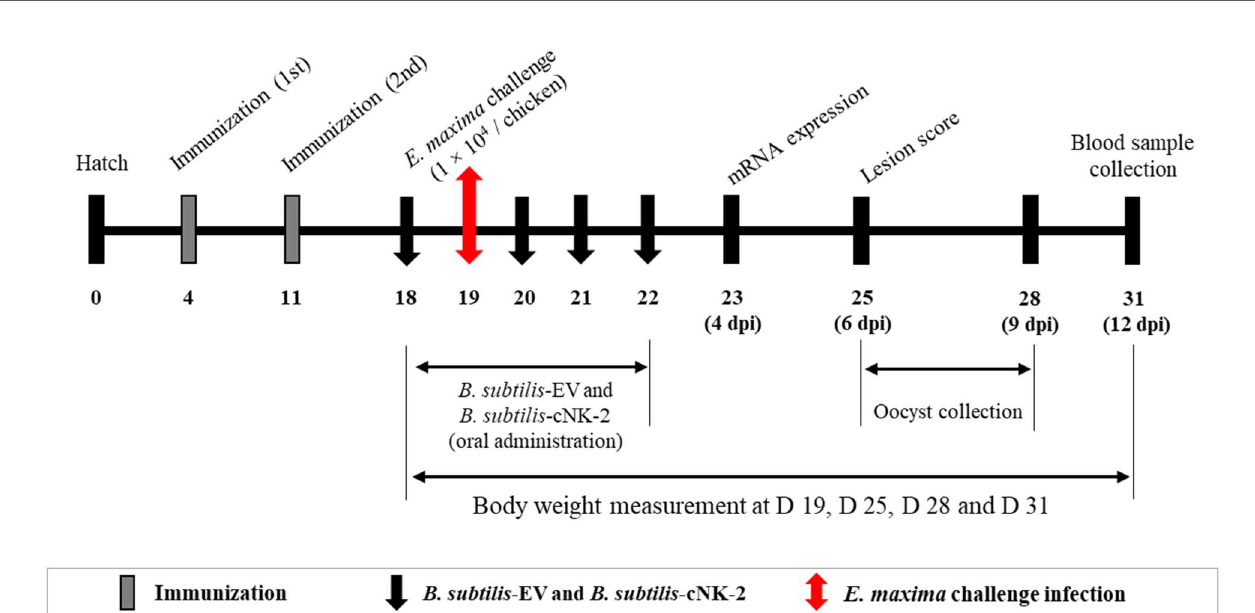
Figure 1. Schematic representation of the experimental designs and treatment information. Chick- ens except the CON and NC groups were immunized on day 4 and 11 with EF-1α, and orally co- immunized with either B. subtilis -cNK-EV or B. subtilis -cNK-2 from day 18 to 22. On day 19, all chickens except the CON group were orally challenge infected with sporulated- E. maxima (1 × 10 4 /chicken). Abbreviations: EV, B. subtilis (empty vector); cNK-2, B. subtilis expressing cNK-2; DPI, days post- E. maxima infection. Table 1. Group information, immunization and Eimeria challenge infection status.